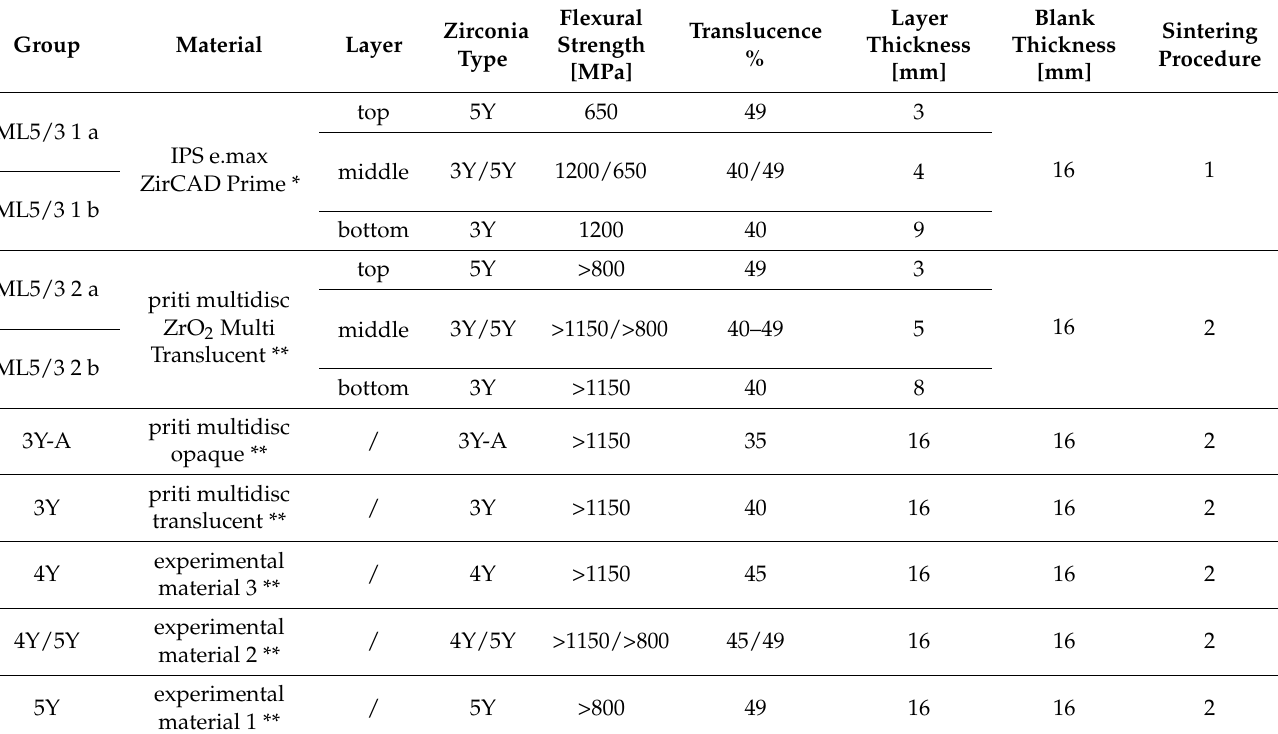
Table 1. Materials, manufacturers’ specifications, sintering